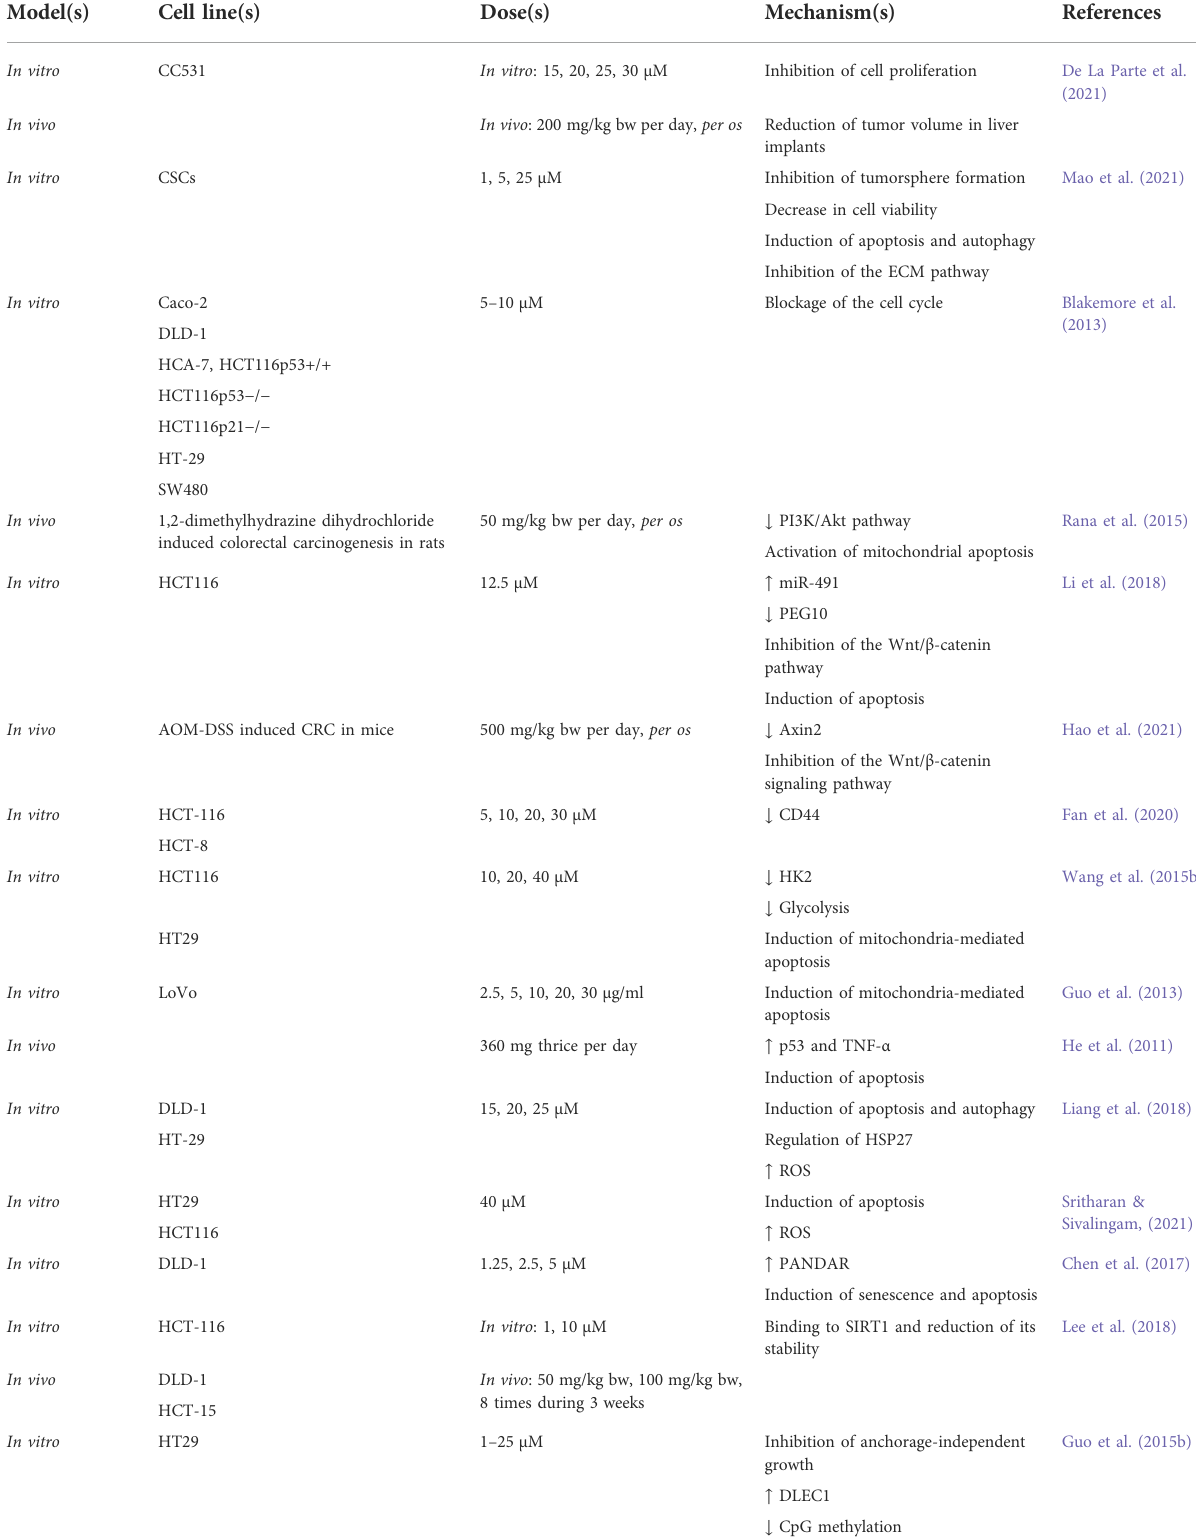
TABLE 2 Pharmacological mechanism underlying the effects of curcumin on colorectal